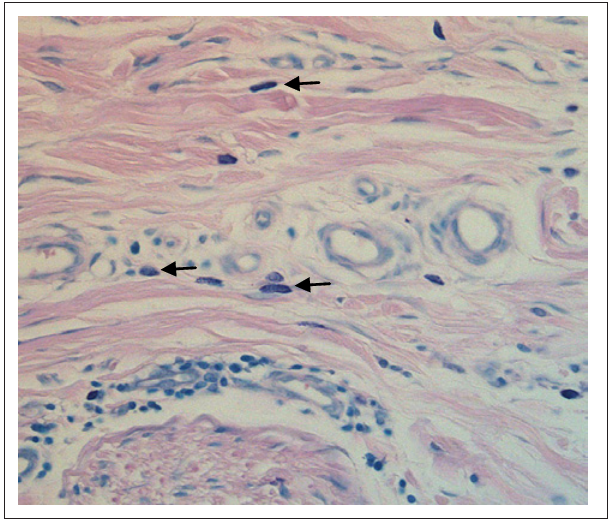
FIGURE 8: Ziehl–Neelsen basophilic granular staining of spindle-shaped mast cells in the dermis (arrows; magnification: 40x). TABLE 1: Results of enzyme-linked immunosorbent assays for bovine viral diarrhoea virus. Sample